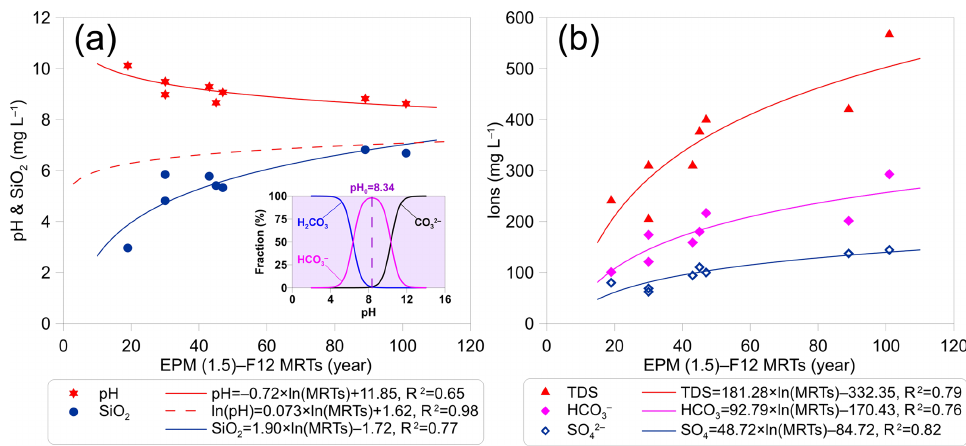
Figure 12. (a) pH and silica (SiO 2 ) and (b) sulfate (SO 2 − (MRTs). The MRTs are from CFC-12 data using the EPM (1.5) model. The dashed red line in (a) is from Morgenstern et al.